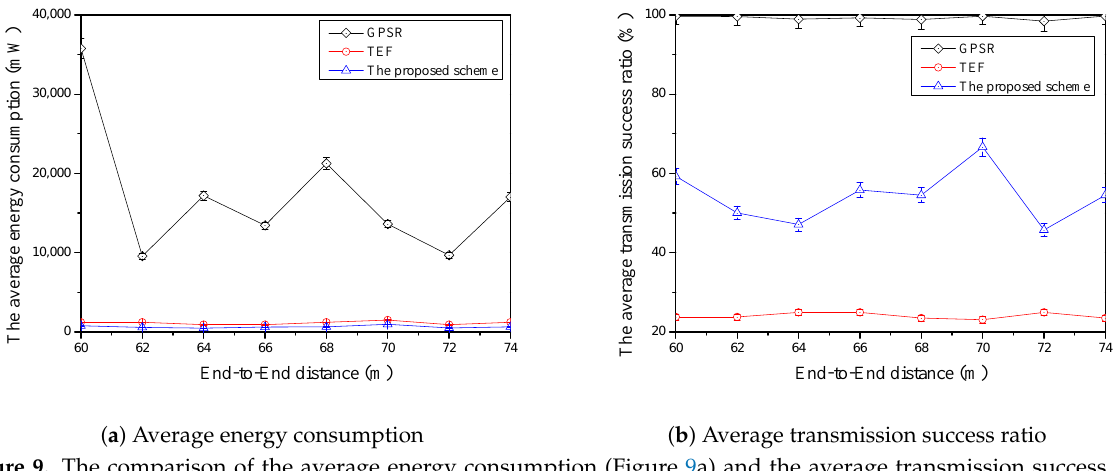
Figure 9. The comparison of the average energy consumption (Figure 9a) and the average transmission success ratio (Figure 9b) according to end-to-end